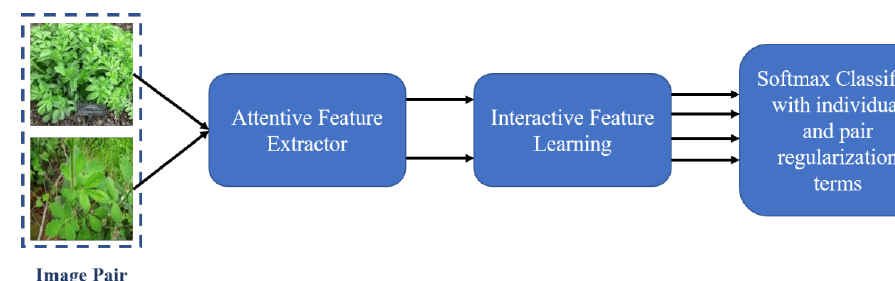
Figure 1. The system framework of